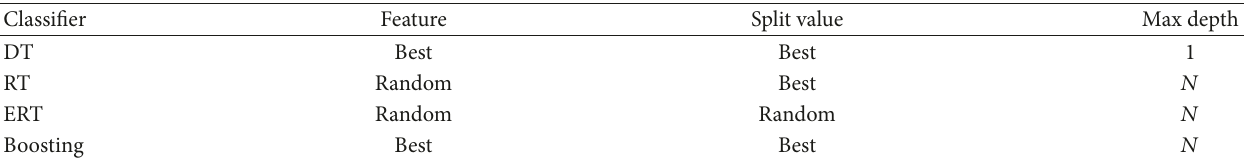
Table 3: Comparison of tree based classifiers depending on the split value and the feature selection. The max depth is the maximum depth of each weak classifier.